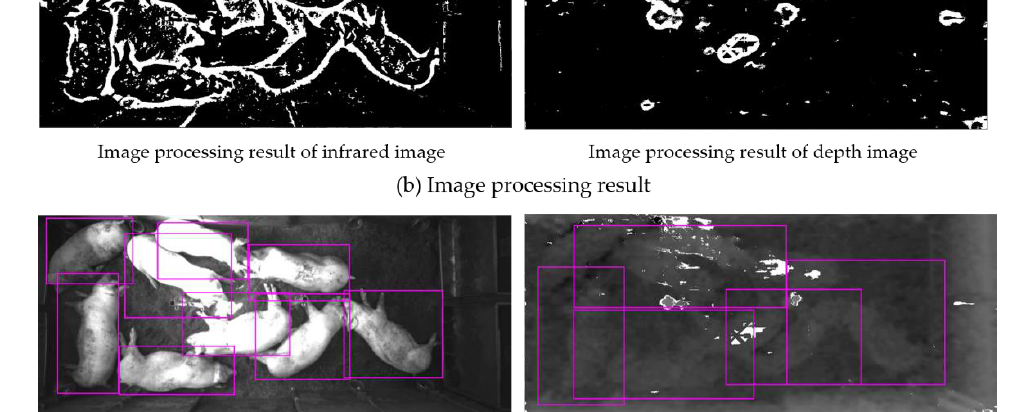
Figure 1. The foreground detection results of the infrared and depth input images with adaptive thresholding [57] and TinyYOLO [58] techniques. Some pig parts are missed, while some background parts are included. Furthermore, it is difficult to detect each individual pig among the pigs in contact with each other. ( a ) Input images ( b ) Image processing results ( c ) TinyYOLO results.